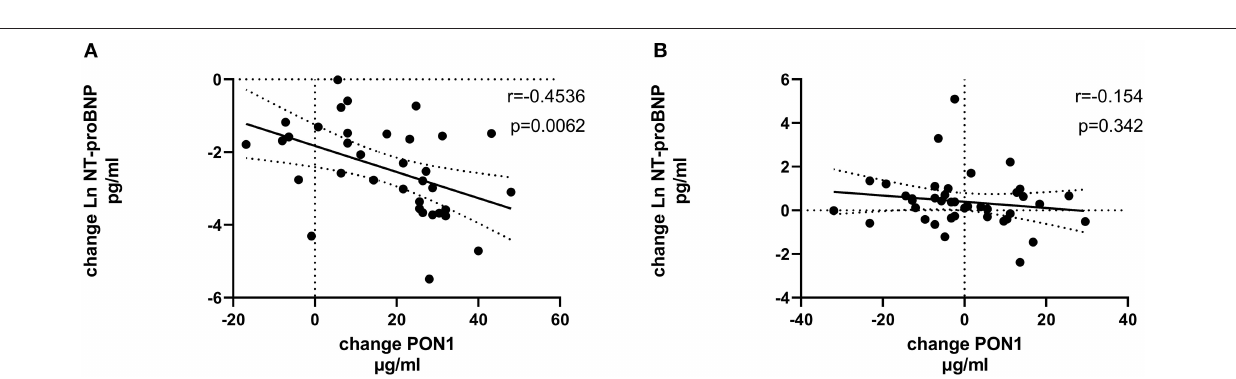
FIGURE 7 | Change in Ln NT-proBNP vs. change in PON1 mass. (A) Transplant group. (B) Dialysis group. Change was calculated as the month 12 value minus the baseline value for each variable. Values shown in the figures are the Pearson correlation coefficient and the p -value. LV, left ventricular; Hb, hemoglobin. LV, left ventricular; LnNT-proBNP, natural log of NT-proB-type natriuretic peptide; PON1, paraoxonase 1; HDLC, high density lipoprotein cholesterol.